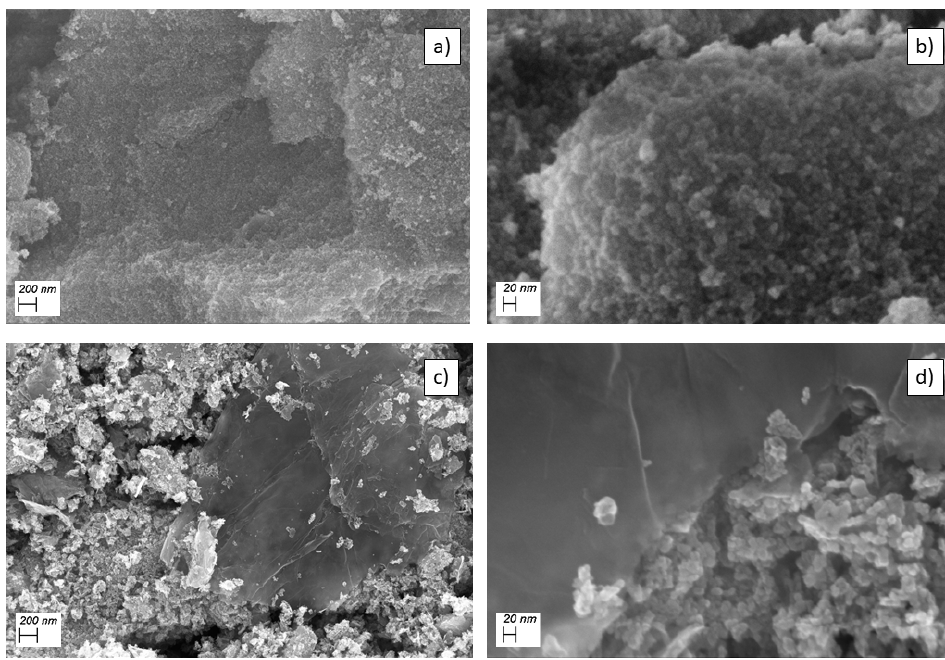
Figure 2. SEM micrographs of pristine Fe 3 O 4 nanoparticles ( a ) at 40,000 × and ( b ) at 275,000 × magnification levels. SEM micrographs of Fe 3 O 4 /rGO ( c ) at 40,000 × and ( d ) at 275,000 × magnification levels.